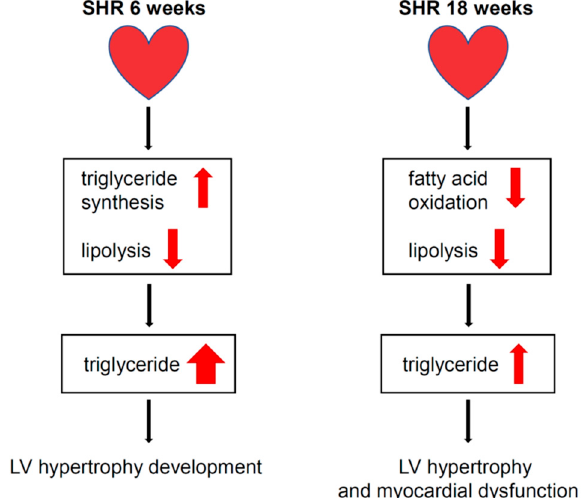
Figure 6. Proposed mechanism leading to cardiomyocyte steatosis, development of LV hypertrophy and myocardial dysfunction in SHRs. The progression of LV hypertrophy and myocardial dysfunction in the SHR6 group was associated with severe TG accumulation, which was associated with increased TG synthesis gene expression and decreased rate of lipolysis in cardiomyocytes. In the SHR18 group, LV hypertrophy and myocardial dysfunction were associated with TG accumulation, which could be attributed to a lower rate of lipolysis and β -oxidation in cardiomyocytes.